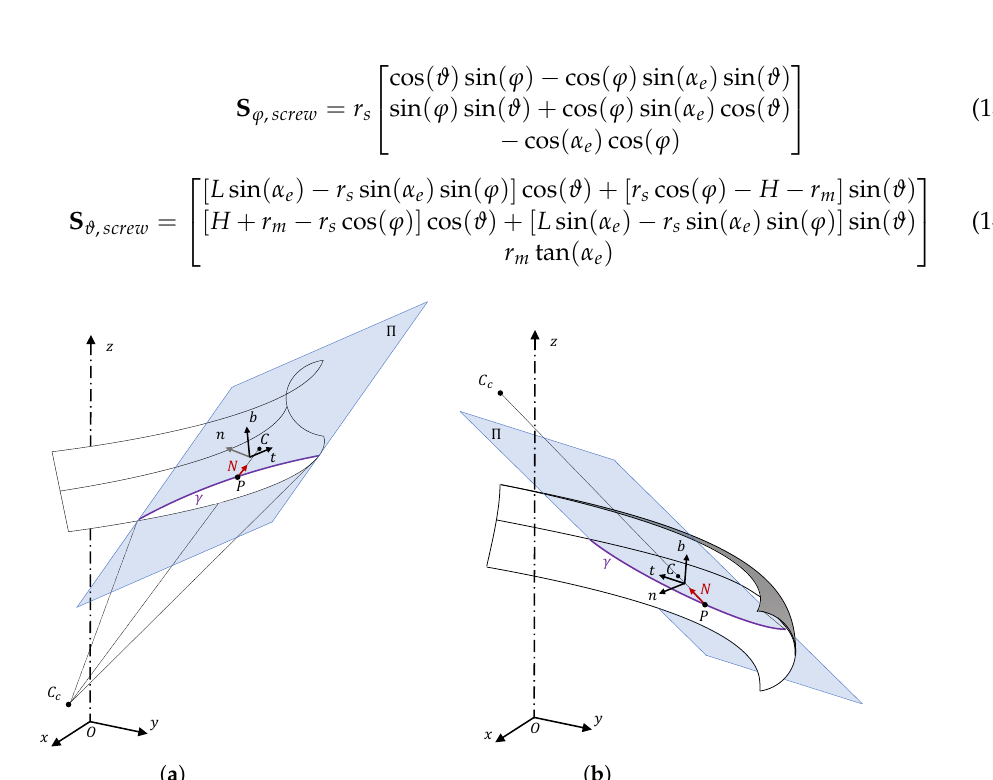
Figure 3. Intersection of the ( a ) screw shaft and ( b ) nut grooves with the Π plane on which one of the two principal curvatures is